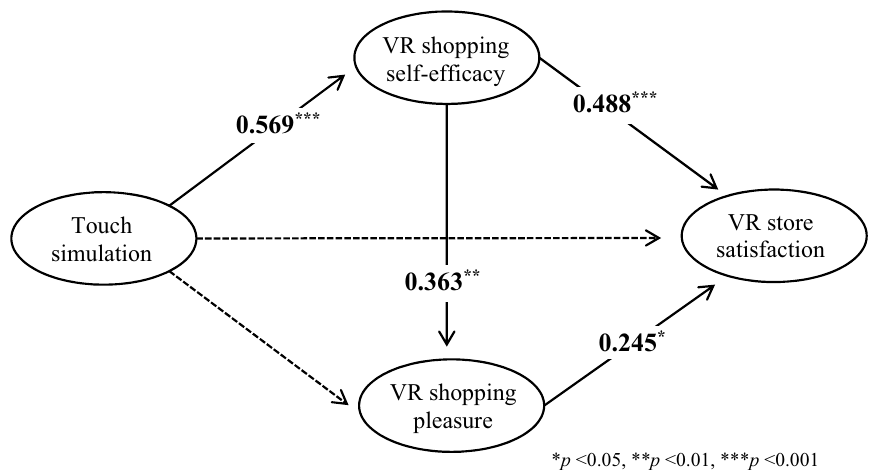
Fig. 2 Mediation model for the effects of touch simulation on VR store